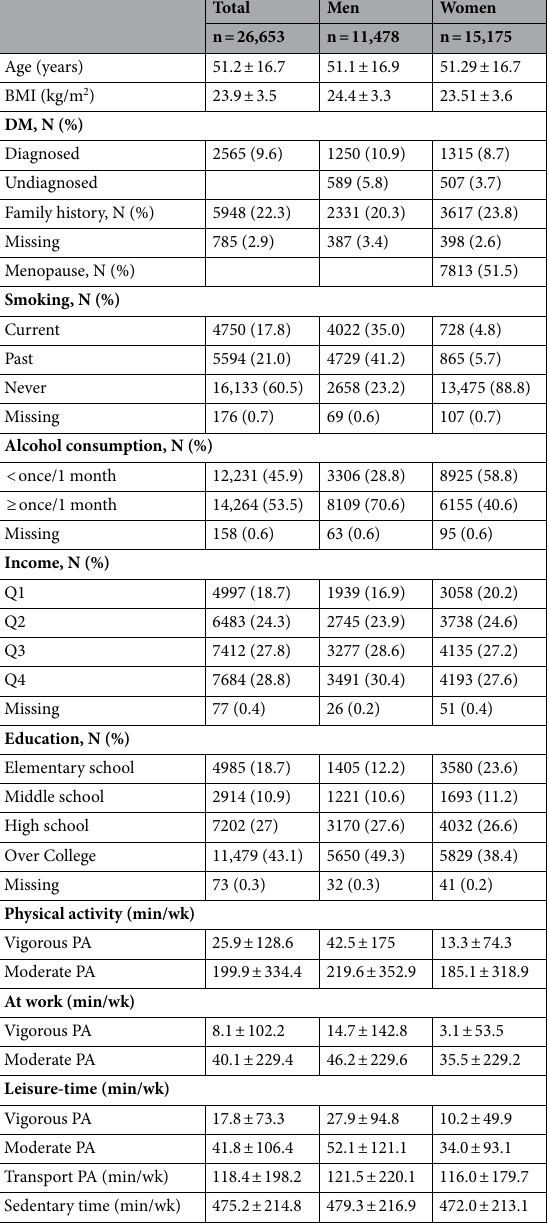
Table 1. Characteristics of participants. Data are presented as mean ± standard deviation or number (percentage). Abbreviation: DM, Diabetes mellitus; PA, physical activity; BMI, body mass index; WC, waist circumference; FG, fasting glucose; TG, triglyceride; SBP, systolic blood pressure; DBP, diastolic blood pressure; TC, total cholesterol; HDL-C, high-density lipoprotein cholesterol; LDL-C, low-density lipoprotein cholesterol; DM, Diabetes mellitus; PA, physical activity; Q,